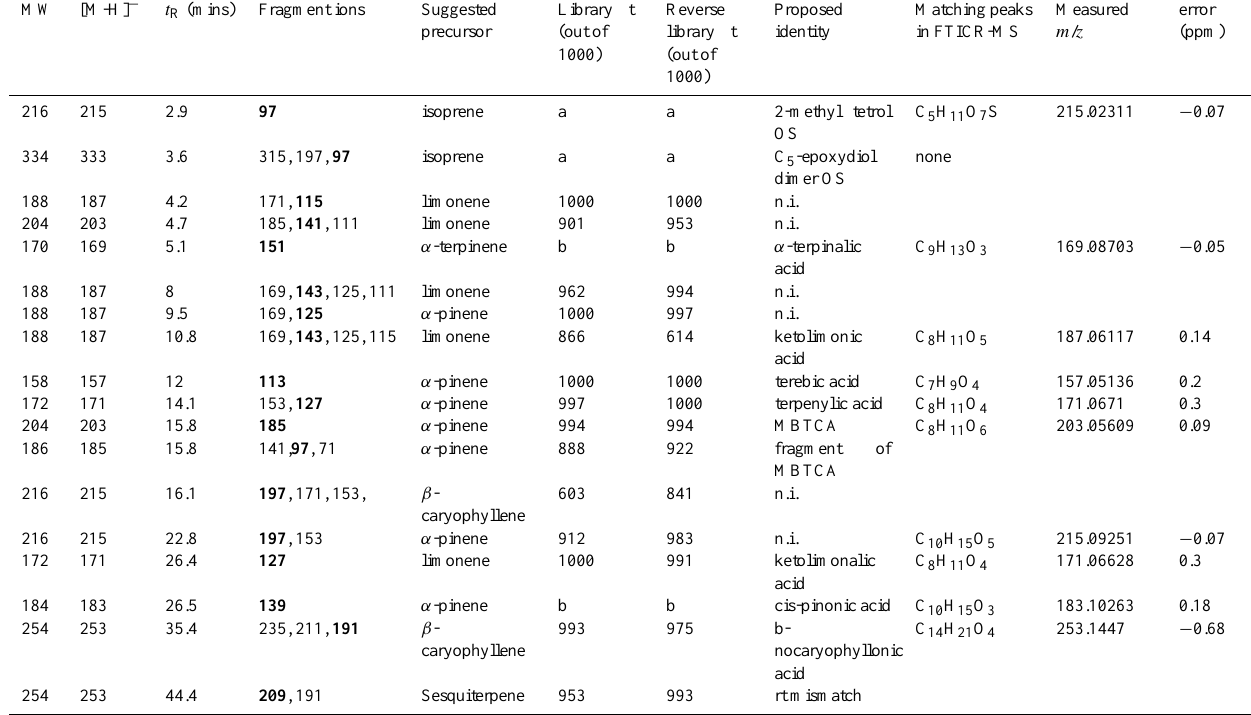
Table 2. BSOA tracer compounds identified using LC-MS 2 in ambient aerosol collected atDanum Valley, Borneo in order of retention on the LC column. Accurate masses were obtained using syringe pump infusion ESI-FTICRMS in negative ionisation mode. Numbers in bold are the base peak in the MS 2 mass